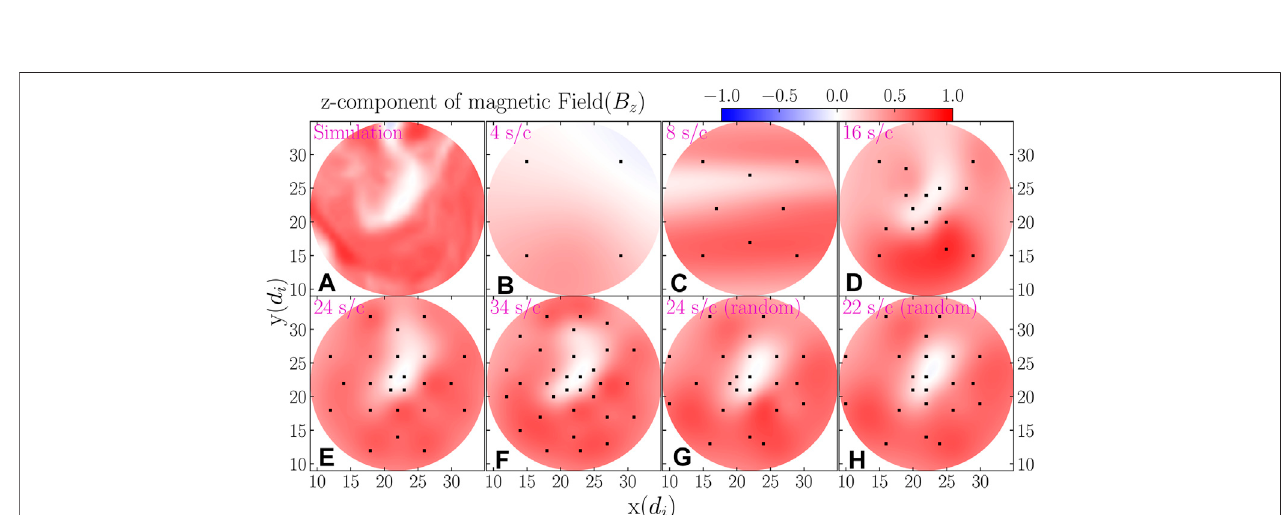
FIGURE A2 | Same as Figure 4 , but for B z , the z -component of the magnetic fi eld.